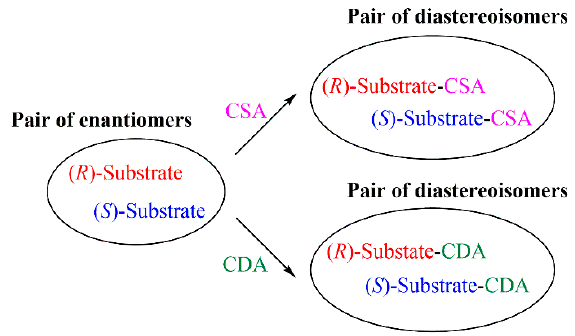
Figure 1. Principle of the enantiomeric differentiation. Molecules 2019 , 24 , 2830; doi:10.3390 /